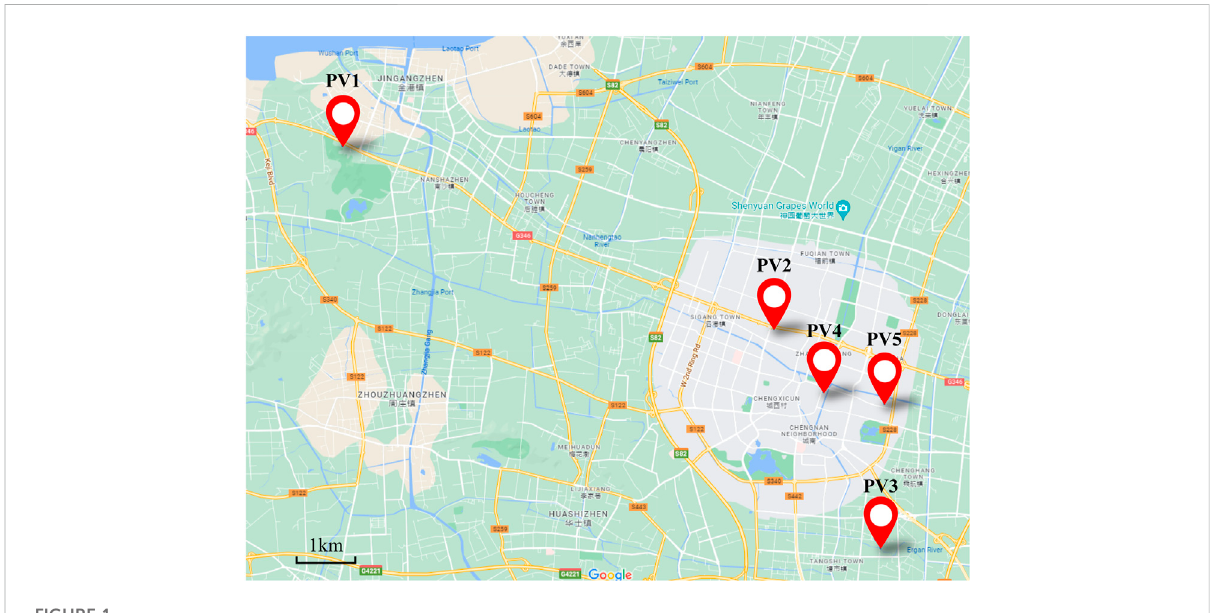
FIGURE 1 Location of fi ve PV